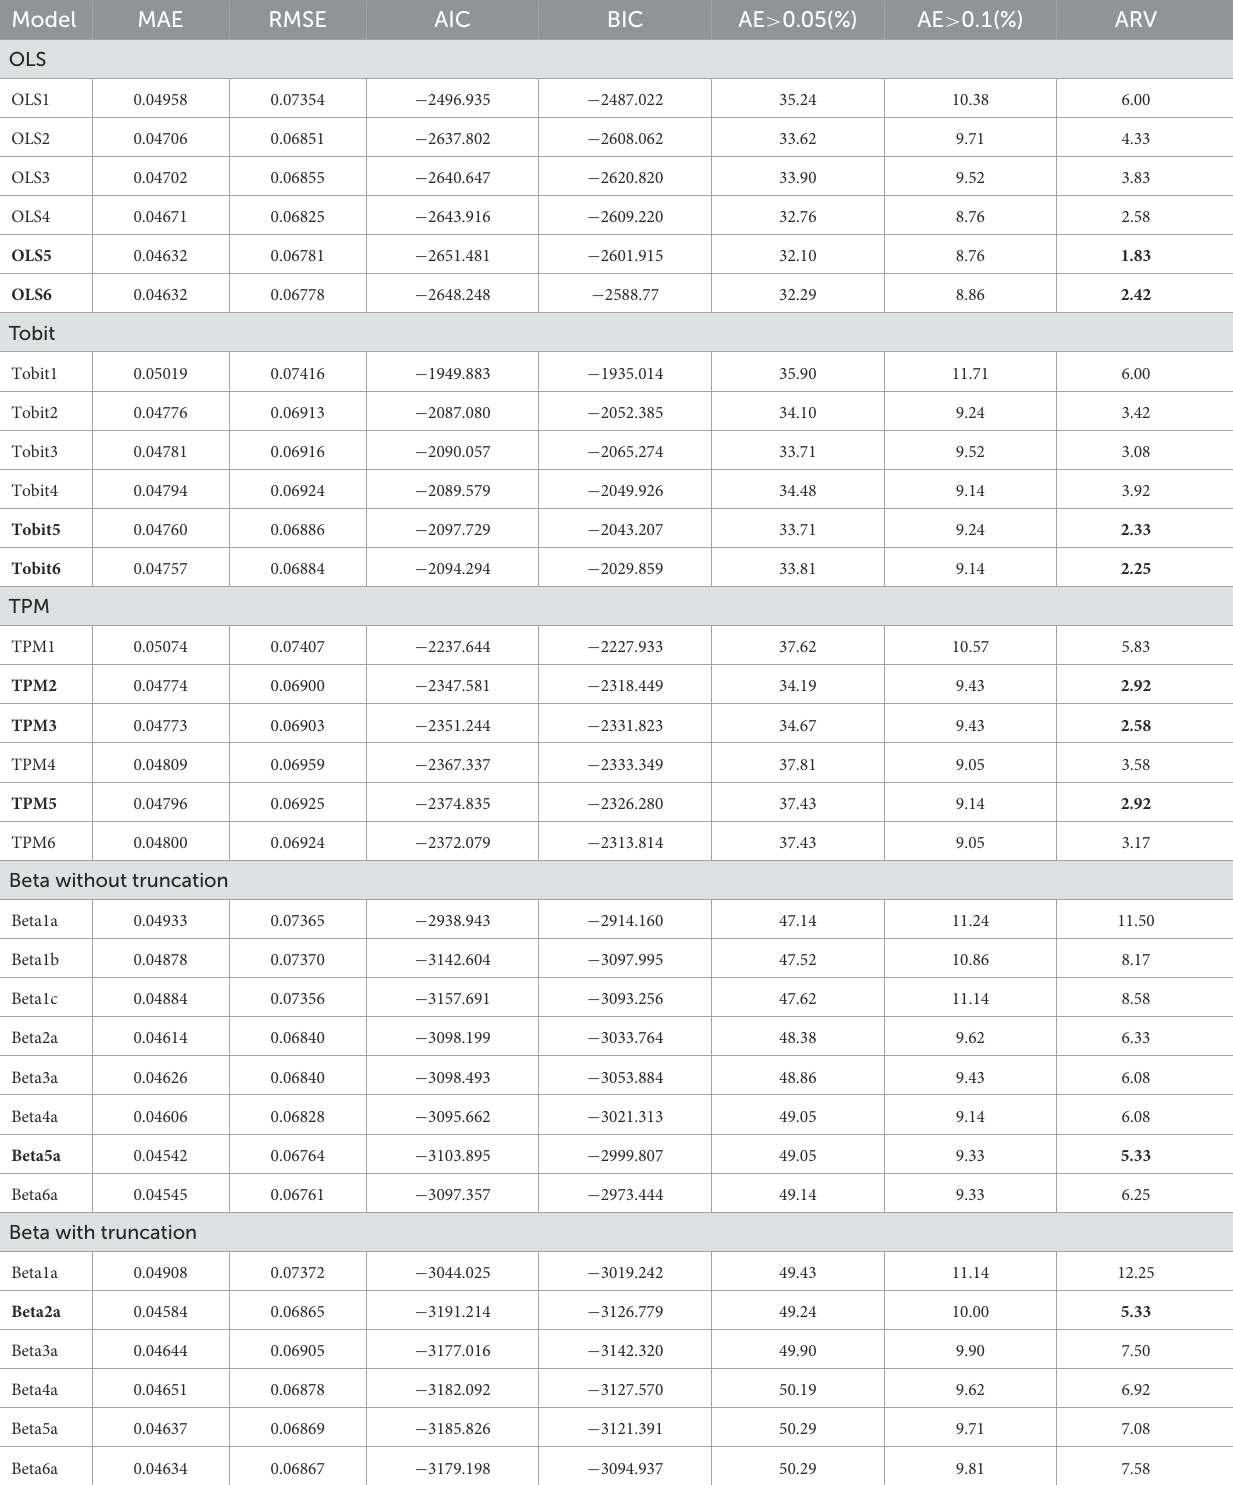
TABLE 3 Model performance of four